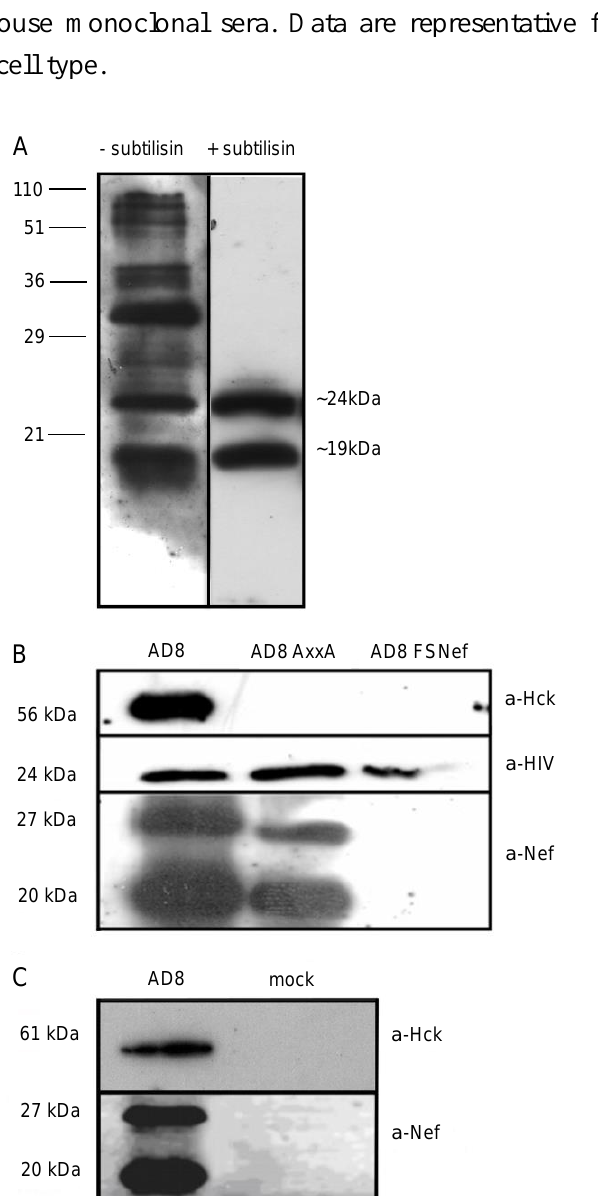
cytoplasmic delivery of the core, core disassembly, formation of the pre-integration complex, reverse